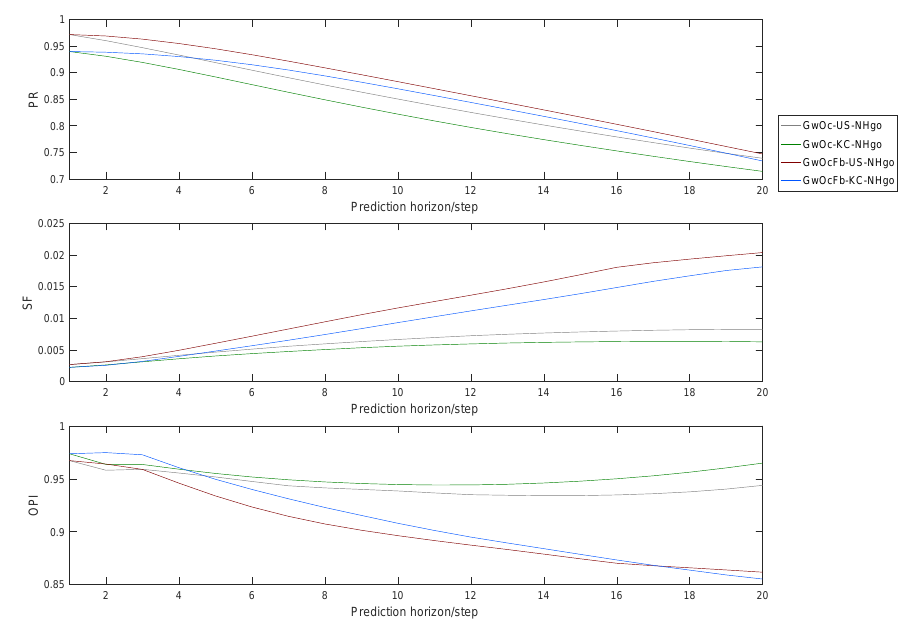
Figure 13. Comparison of the prediction performance of the GwOc-KC-NHgo, GwOc-US-NHgo, GwOcFb-KC-NHgo, GwOcFb-US-NHgo methods (left hip joint data in the sagittal plane). 4.